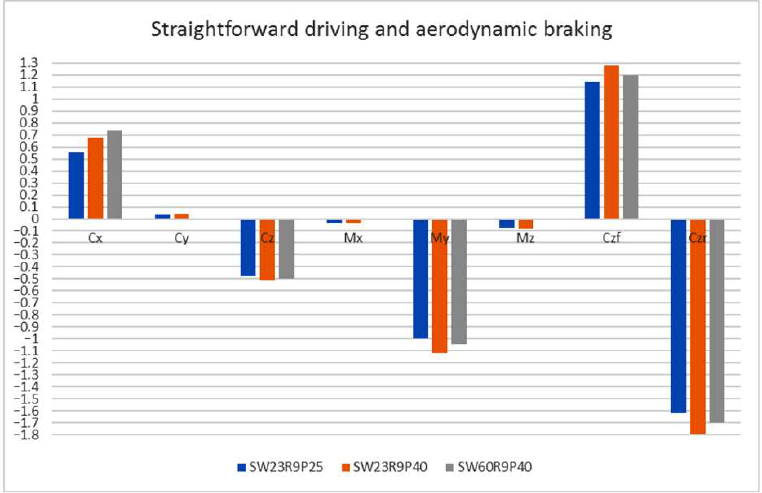
Figure 24. Comparison of aerodynamic coefficients of car with wing in three configurations: SW23R9P25-wing tilted 9 degrees, angle of attack 23 degrees, booster plate angled at 25 degrees, SW23R9P25-wing tilted 9 degrees, angle of attack 23 degrees, booster plate angled at 40 degrees, and SW60R9P40-wing tilted 9 degrees, angle of attack 60 degrees, and booster plate angled at 40 degrees.